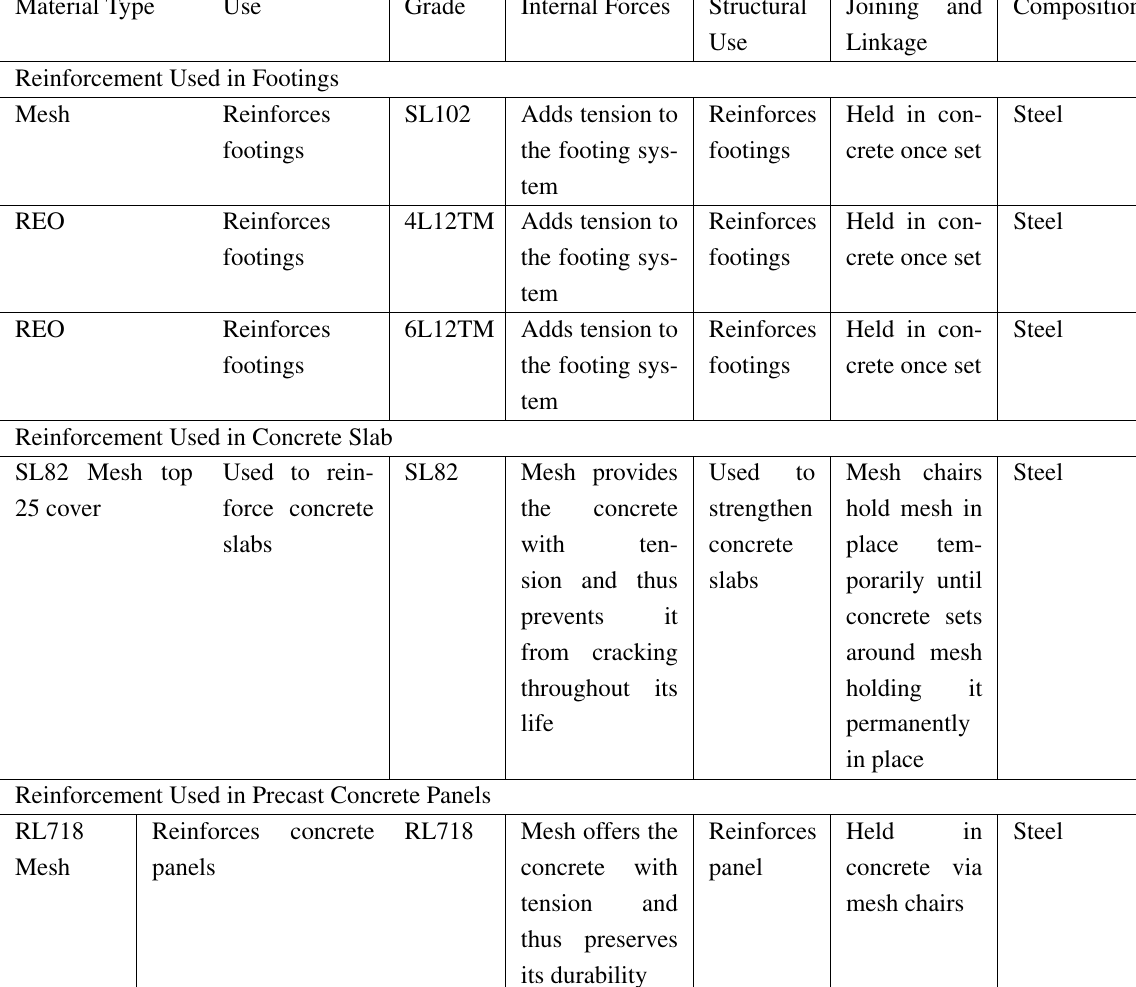
Table 1. Steel usage in